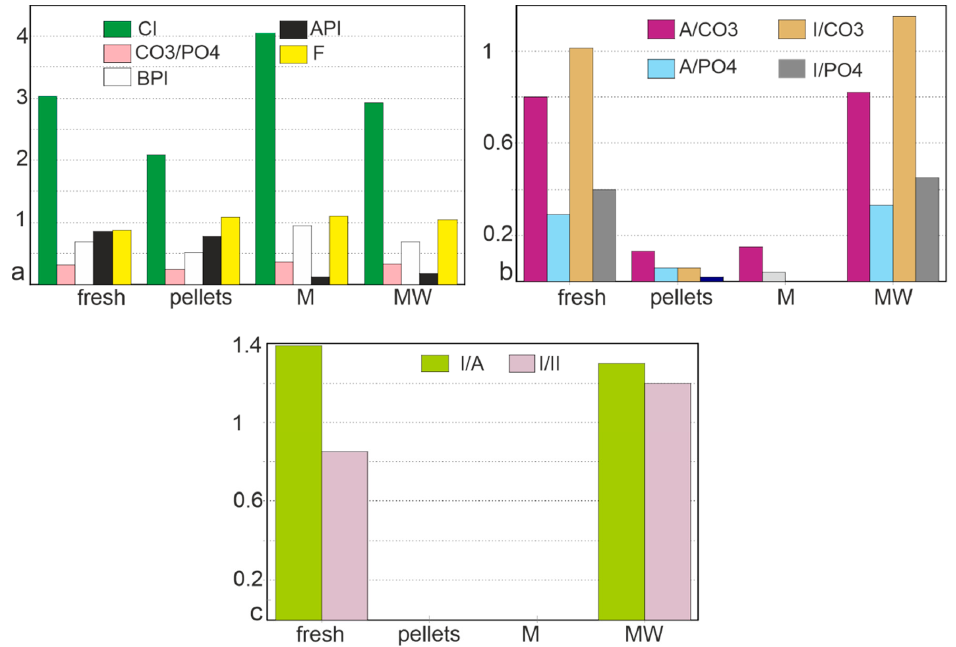
Figure 9. ( a ) Crystallinity (CI), CO 3 /PO 4 ratios, type B carbonate to phosphate substitution (BPI), type Figure 10. ( a ) Crystallinity (CI), CO 3 / PO 4 ratios, type B carbonate to phosphate substitution (BPI), type A A carbonate to phosphate substitution (API) and F content (F) calculated from FTIR spectra. ( b ) carbonatetophosphatesubstitution(API)andFcontent(F)calculatedfromFTIRspectra. ( b )Organo–mineral Organo–mineral ratios based on amide A (A), amide I (I), CO 3 and PO 4 bands, calculated from FTIR ratiosbasedonamideA(A),amideI(I),CO 3 andPO 4 bands,calculatedfromFTIRspectra. ( c )AmideI / amide spectra. ( c ) Amide I/amide A ratio and amide I/amide II ratio from FTIR spectra. M: Malema, MW: A ratio and amide I / amide II ratio from FTIR spectra. M: Malema, MW: Mwenirondo.